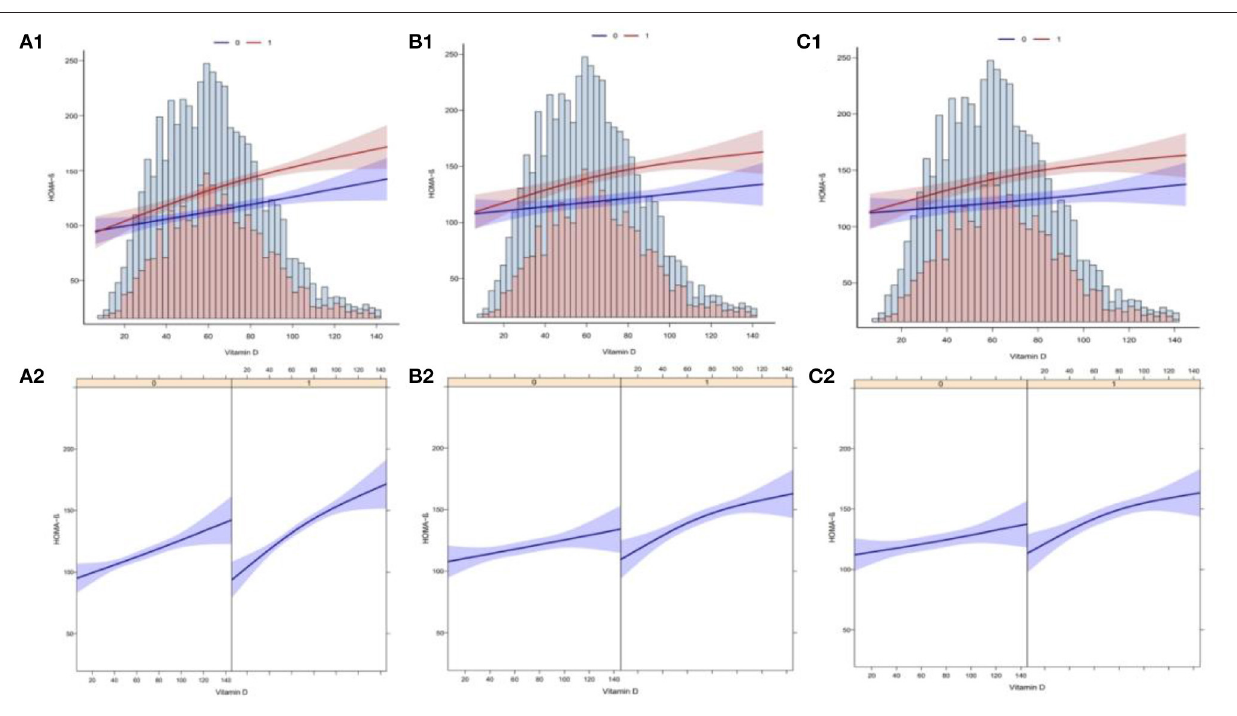
FIGURE 4 | Curve fitting of Vitamin D levels and the risk of HOMA- β index. (A1) The association between VD and HOMA- β with no adjustment for covariates (Model 1). (A2) The association between VD and HOMA- β with no adjustment for covariates (Model 1). (B1) The association between VD and HOMA- β with the adjustment of age, gender and race (Model 2). (B2) The association between VD and HOMA- β with the adjustment of age, gender and race (Model 2). (C1) The association between VD and HOMA- β with the adjustment other covariates (Model 3). (C2) The association between VD and HOMA- β with the adjustment other covariates (Model